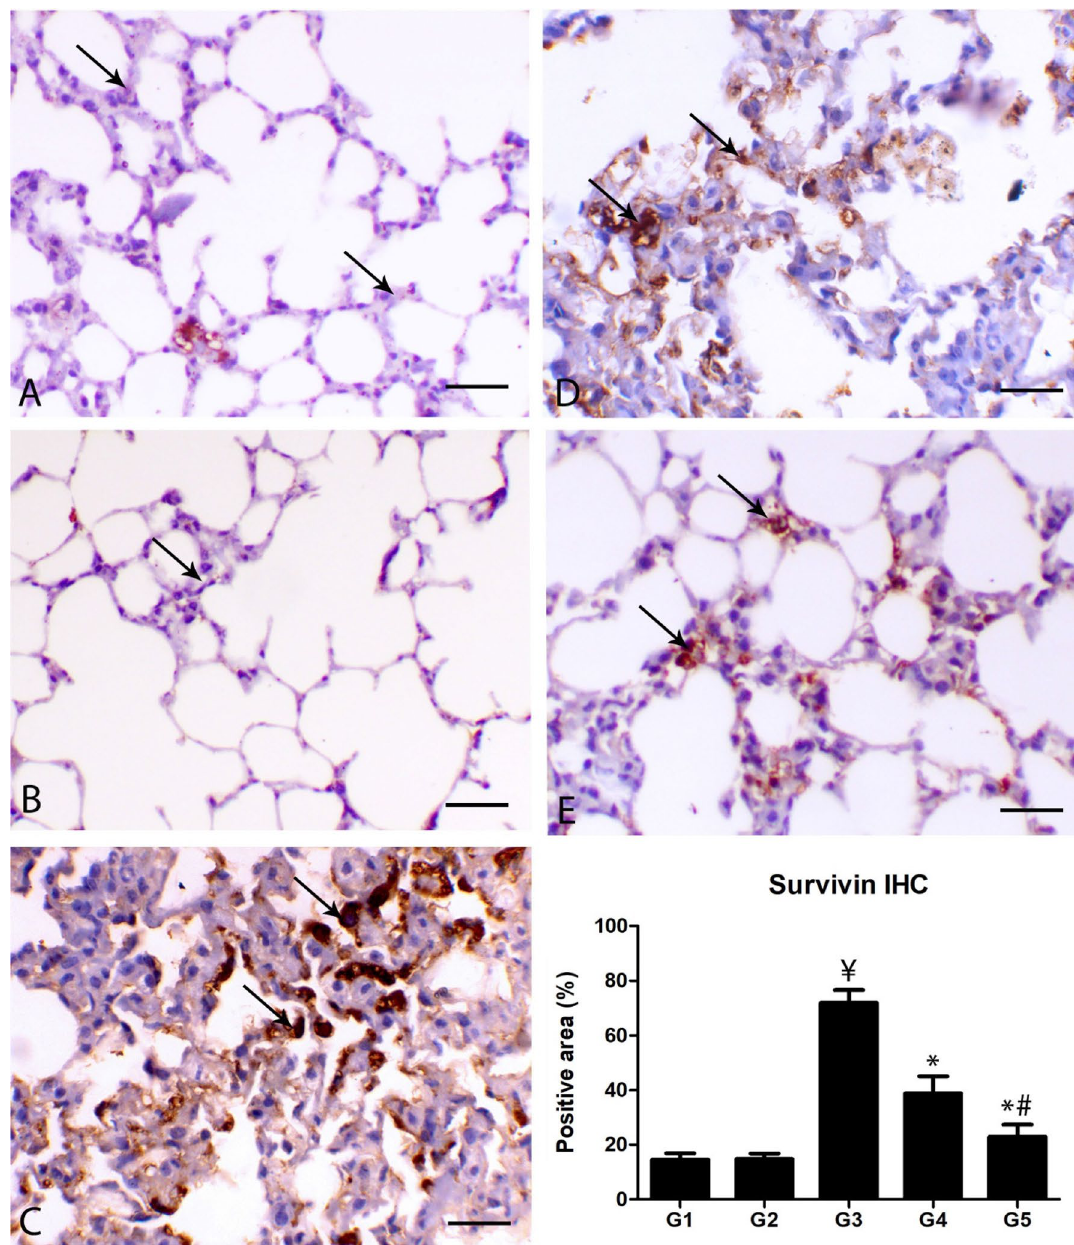
Figure 5. Photomicrograph of the pulmonary sections of the different groups immunostained with surviving antibody. (A) The lung of G1 and (B) lung of G2 showing mild expression of surviving within the alveolar cells. Normal alveoli and bronchi. (C) Lung of G3 showing marked expression within the proliferated alveolar cells mostly alveolar type II. (D) Lung of G4 showing decrease of survivin expression within the alveolar cells. (E) Lung of G5 showing marked decrease of survivin expression within the alveolar cells, bar = 50 µm. (F) Quantitative score of the percent of positive areas showing survivin expression. ¥ indicates significance in comparing with G1 (P < 0.005), * indicates significance in comparison with G3 (P < 0.005) and # indicates significance in comparison with G4 (P <